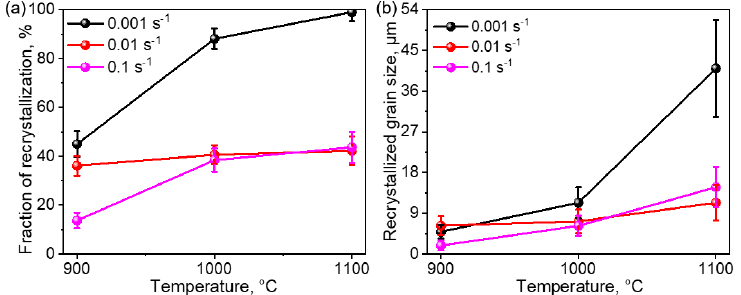
Figure 11. The volume fraction ( a ) and average grain size ( b ) of the dynamically recrystallized grains in the (CoCrNi) 94 Ti 3 Al 3 alloy hot-compressed to a true strain of 1.0. The compression temperature is 850, 900, 950, and 1000 °C, and the strain rate is 0.001, 0.01, and 0.1 s − 1 .